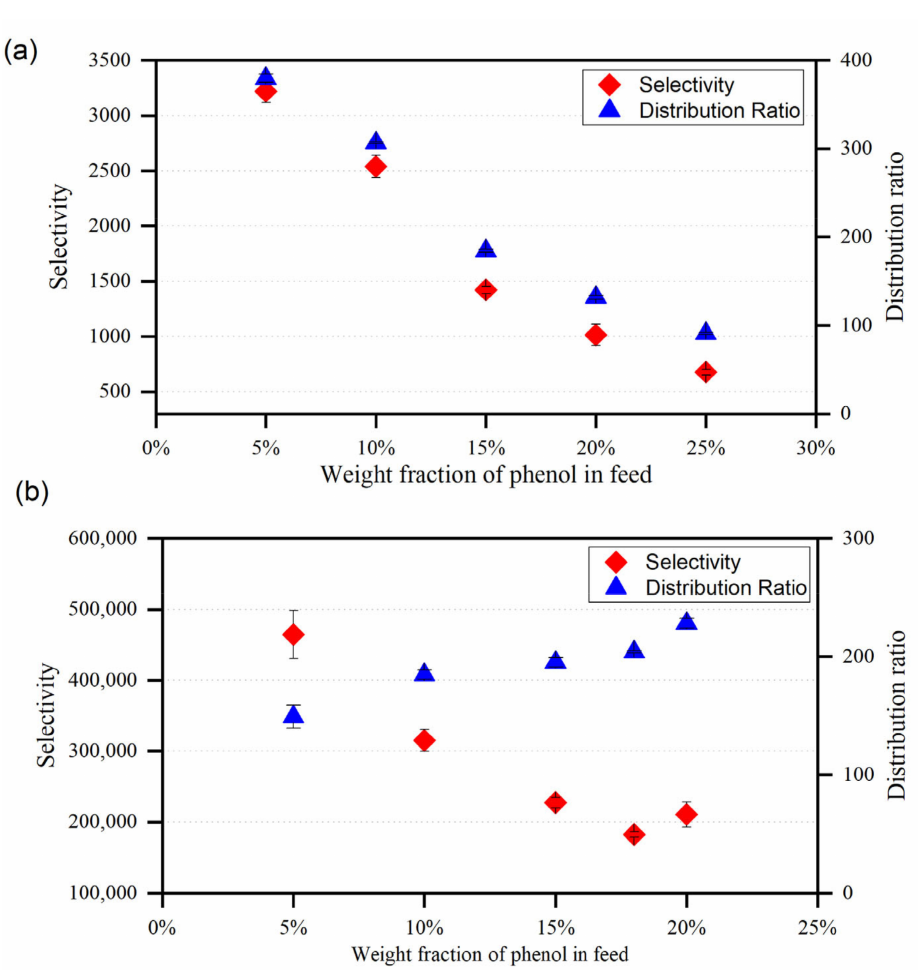
Figure 11. Variation of the selectivity and distribution ratio with phenol mole fraction in the feed for